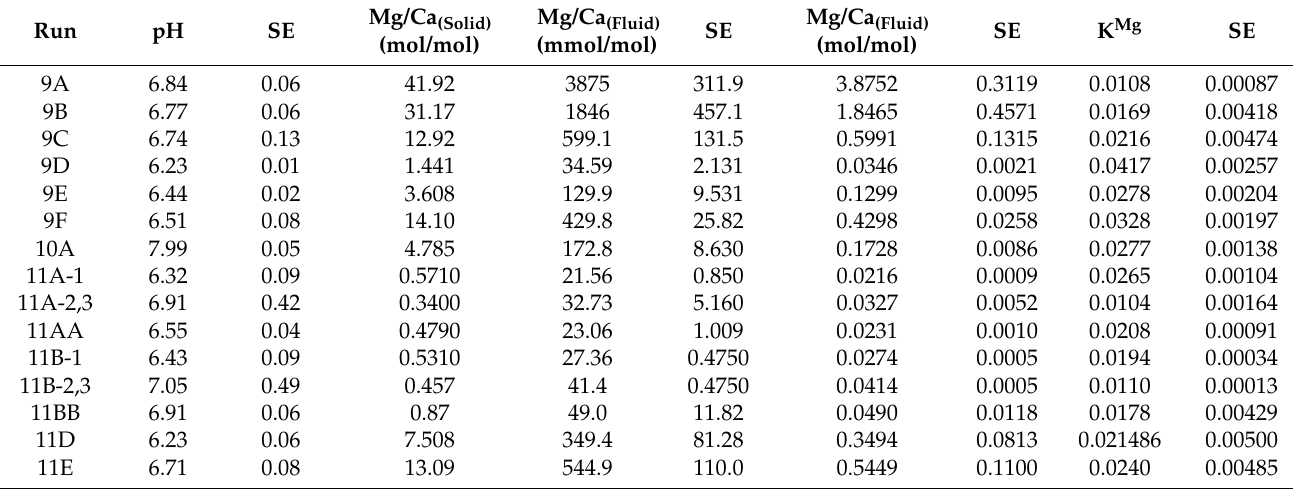
Table 3. Solid and aqueous Mg/Ca, K Mg.